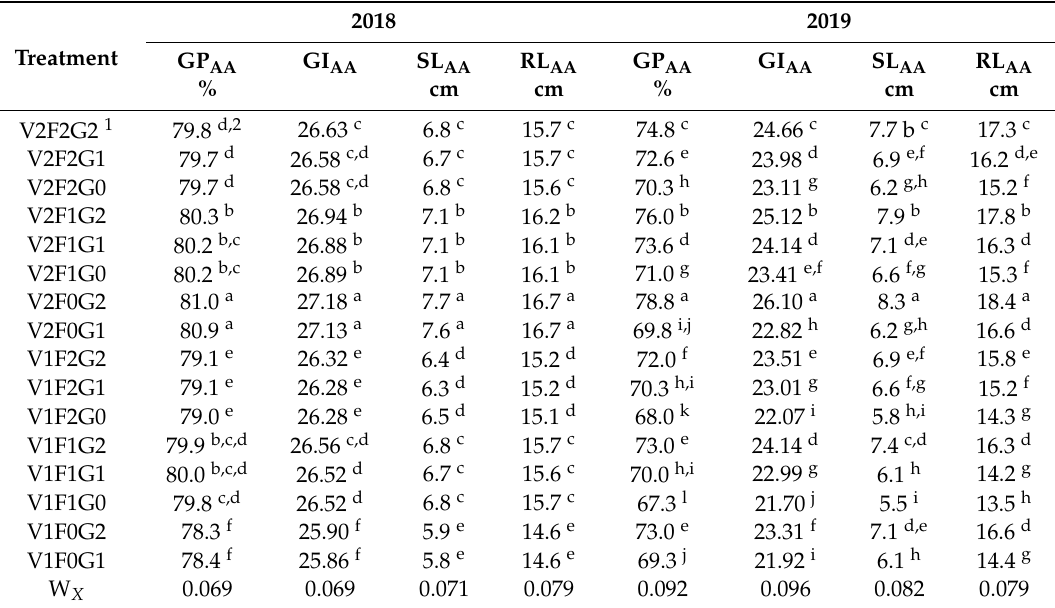
Table 6. Germination percentage (GP), germination index (GI), seedling length (SL), and root length (RL) on the 7th day of accelerated aging (AA) test under di ff erent irrigation treatments and weight determined using the entropy weight method (W X ) in 2018 and 2019.